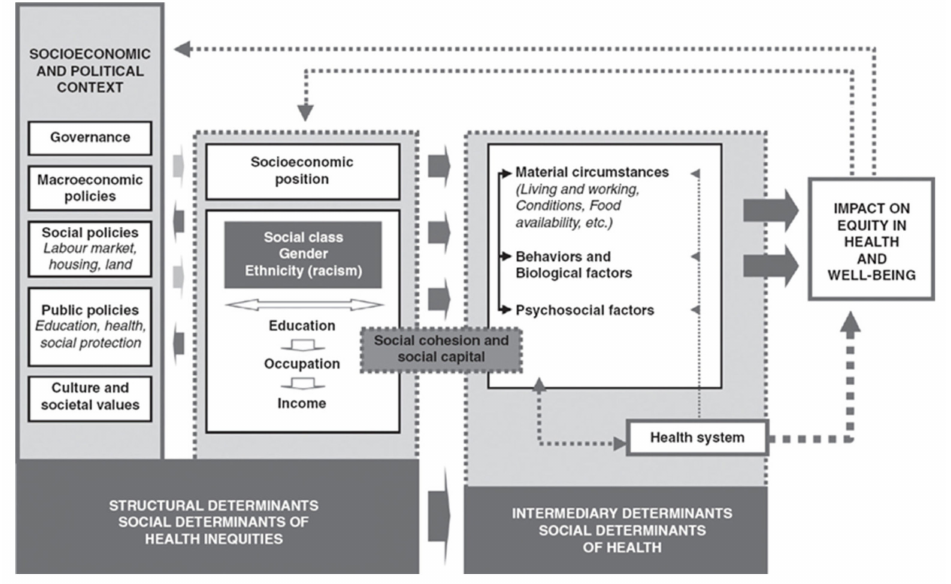
Figure 1. Social determinants of health. WHO Commission on Social Determinants. Source: Solar and Irwin (3)